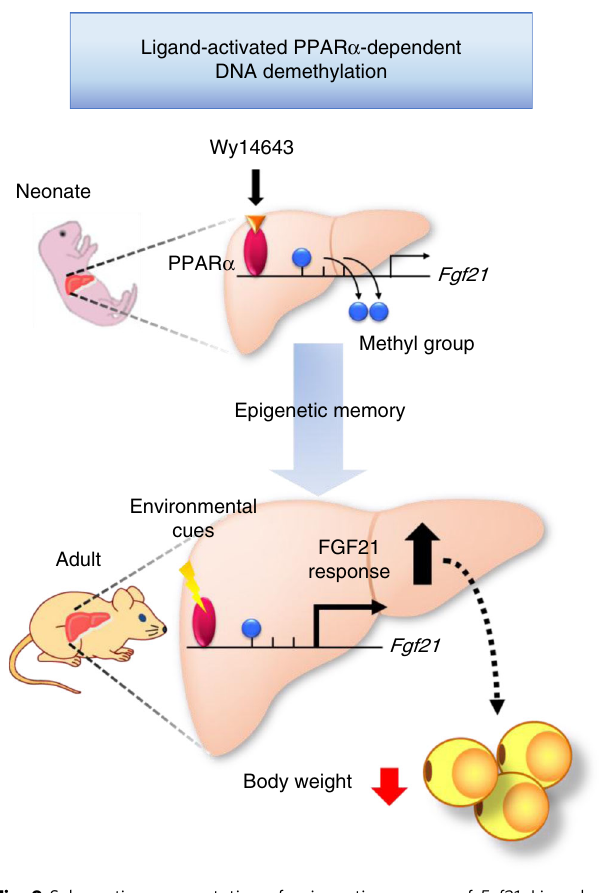
Fig. 9 Schematic representation of epigenetic memory of Fgf21 . Ligand- activated PPAR α induces DNA demethylation of Fgf21 in the postnatal mouse liver; DNA methylation status of Fgf21 , once established in early life, persists into adulthood, as an epigenetic memory. In adulthood, DNA methylation status determines the magnitude of Fgf21 expression response to environmental cues. This may lead to the reduction of body weight and adipose tissue mass during HFD feeding in